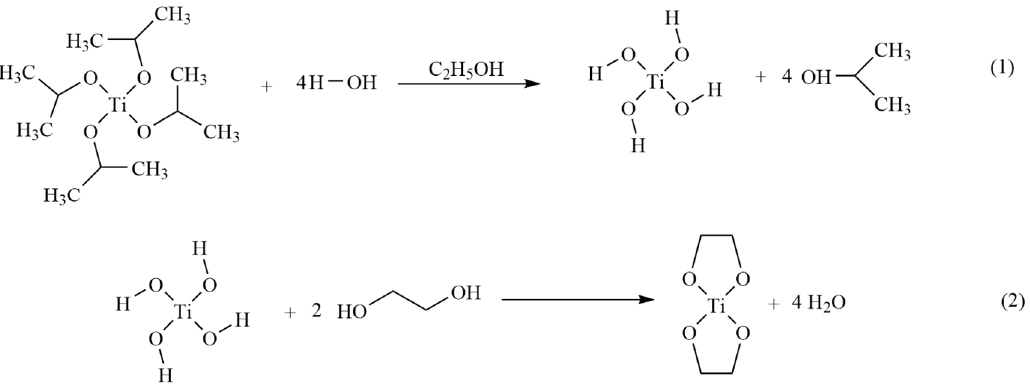
Figure 1. Synthesis route of titanium ethylene glycol nanocatalyst.